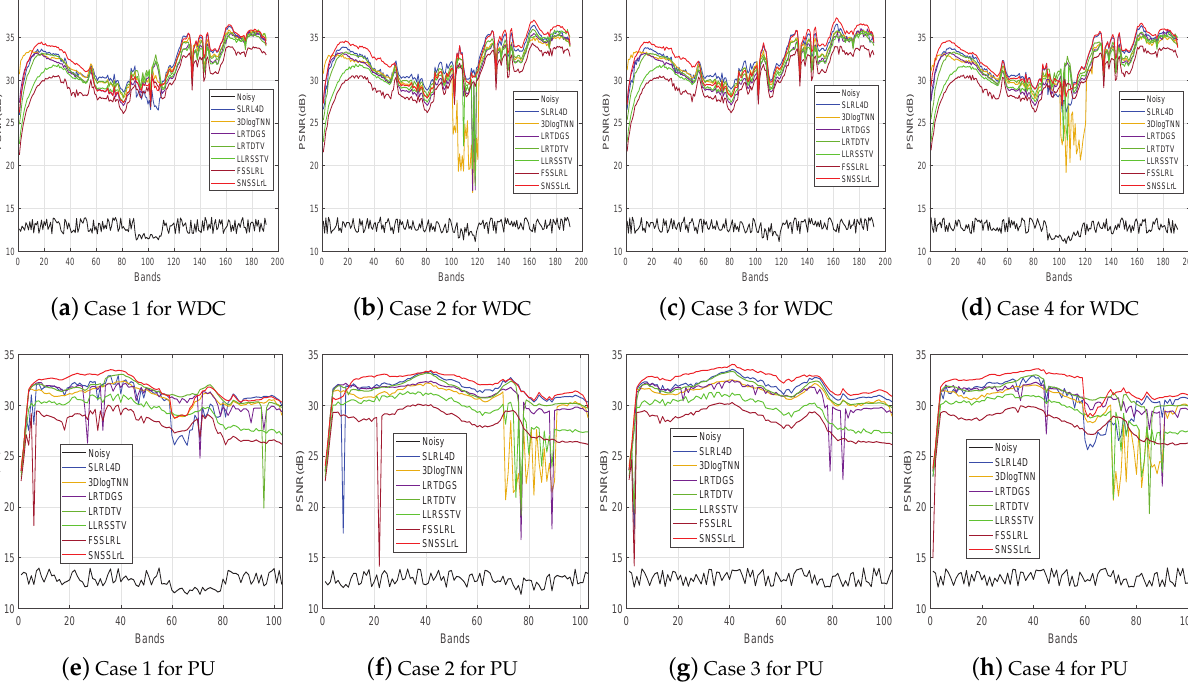
Figure 8. MPSNR as a function of bands for case 1 to case 4 of WDC and PU